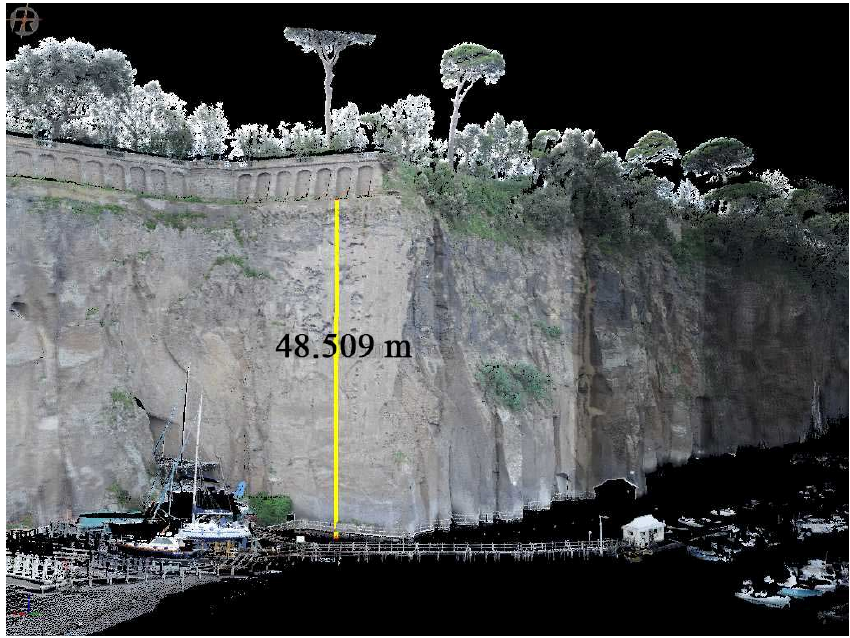
Figure 6. Texturized point cloud at the Santa Caterina cliff. The yellow vertical line provides the height of the cliff.